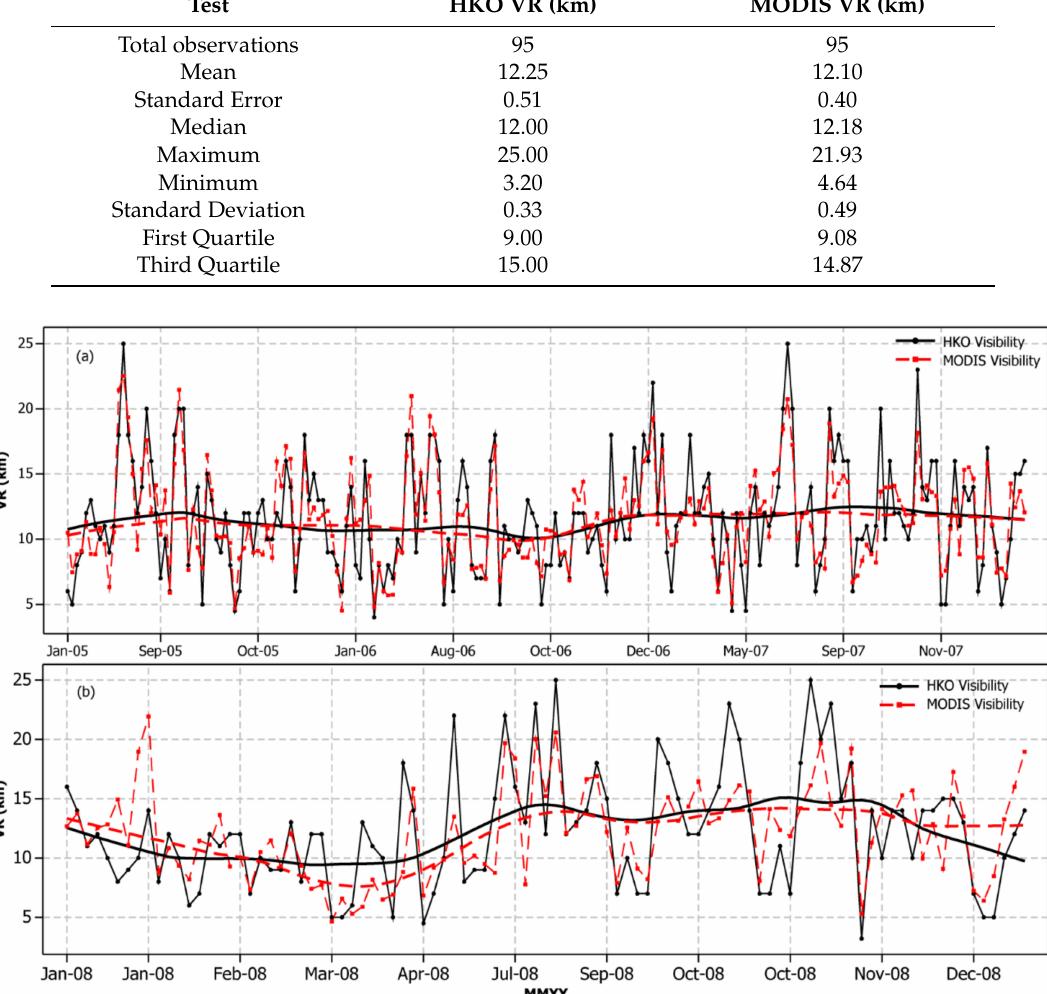
Figure 13. Time series of the real-time and simulated VR at HKO using Model 2 for the ( a ) Training data set of 2005–2007; and ( b ) Validation data set of 2008. Black solid line and dotted red line show the smoothed trend line for HKO and MODIS visibility,